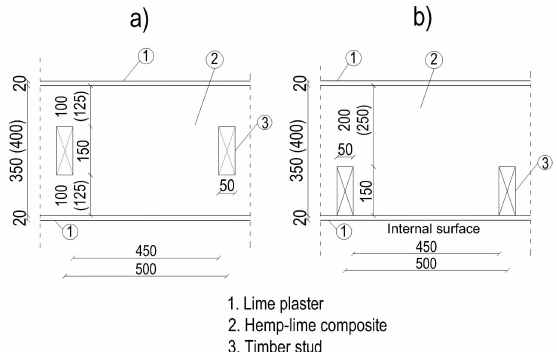
Figure 3. External walls with a timber frame construction located centrally with respect to the wall thickness ( a ) and at the inner side of the wall ( b ). Dimensions in mm.